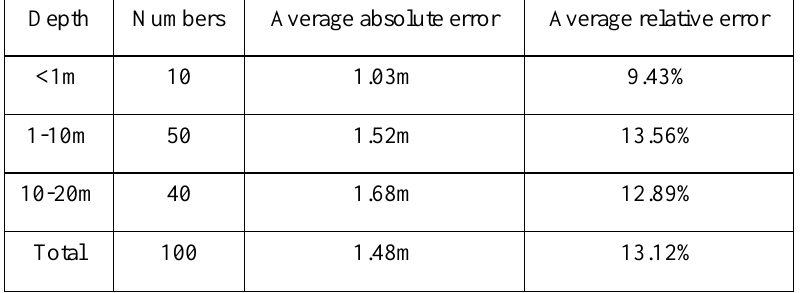
Table 1. Evaluation results of the